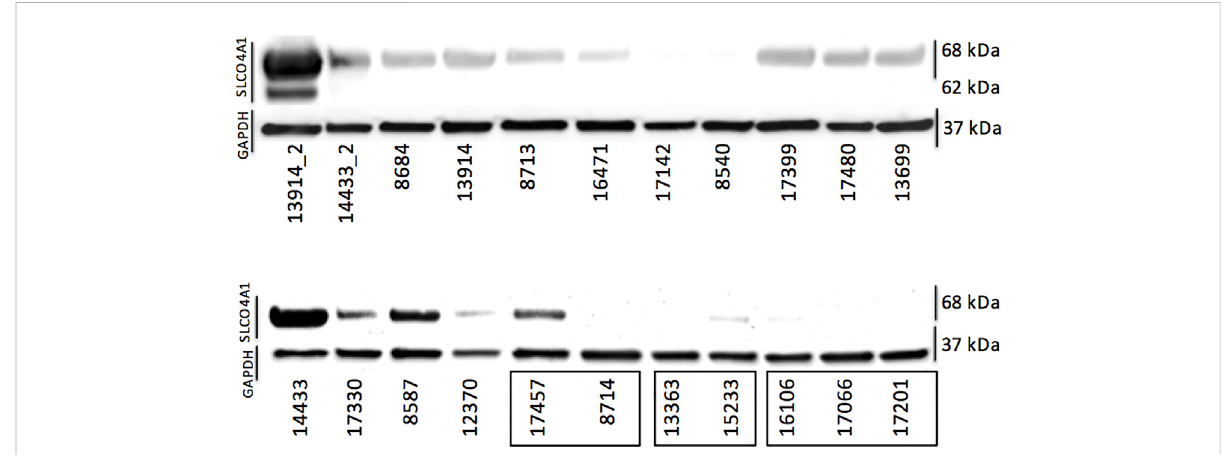
FIGURE 2 Protein levels of OATP4A1 determined via Western blotting. The fi rst two samples (13914_2 and 14433_2) are primary cell cultures containing mostly mesothelial cells. The three clusters on the bottom right (indicated with black rectangles) are cell lines derived from the same patient; all others are single cell lines generated from different patients. GAPDH was used as loading control.